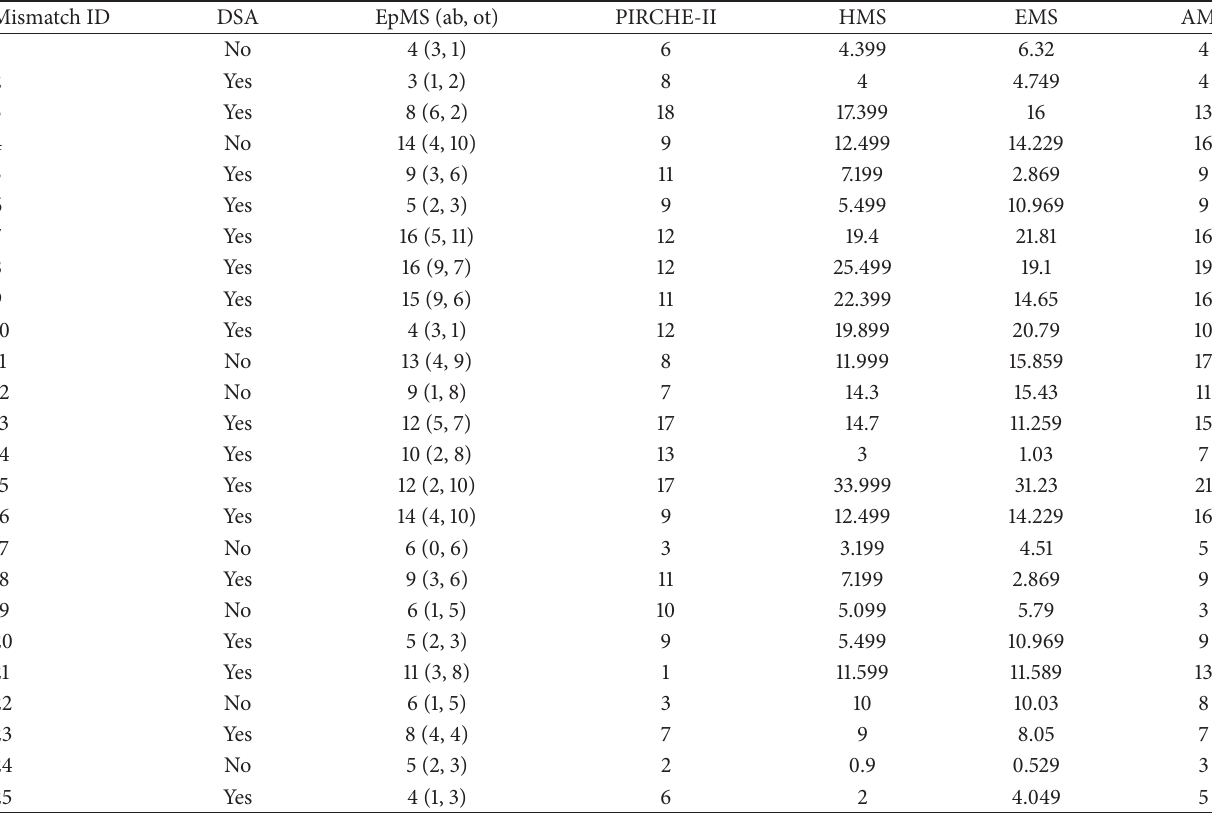
Table 2: HLA class II mismatch